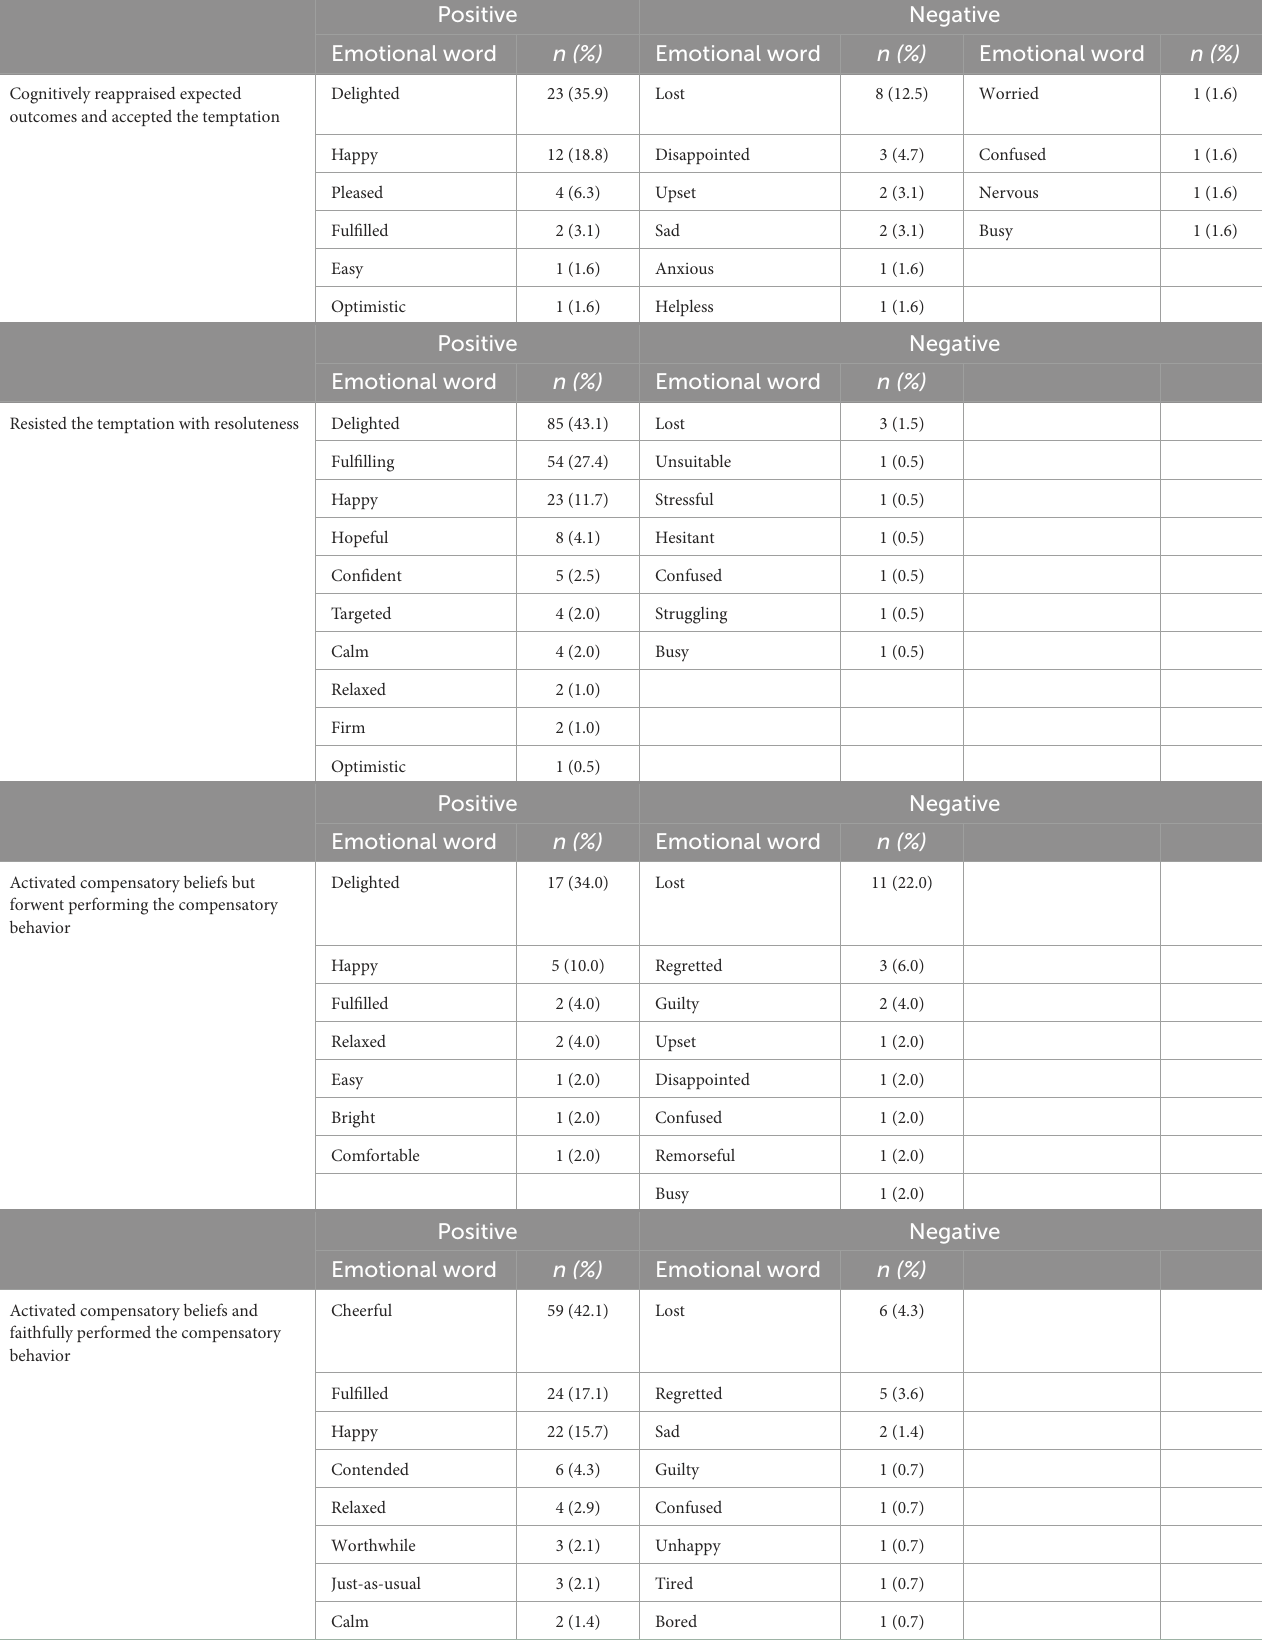
TABLE 3B Emotional word coding table (organizational employees). Positive Negative Emotional word n (%) Emotional